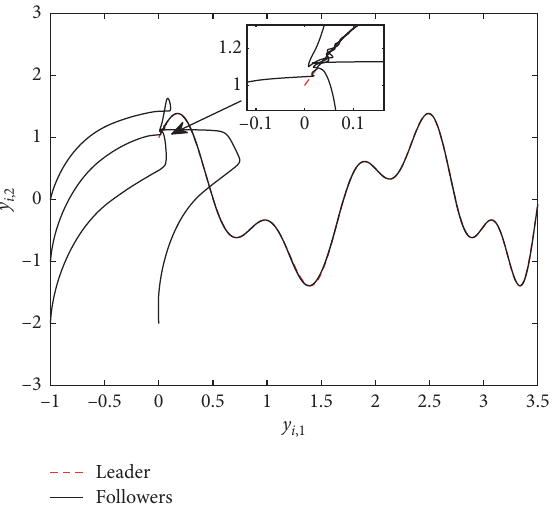
Figure 2: Output trajectories of the followers with one leader in the 2D space.